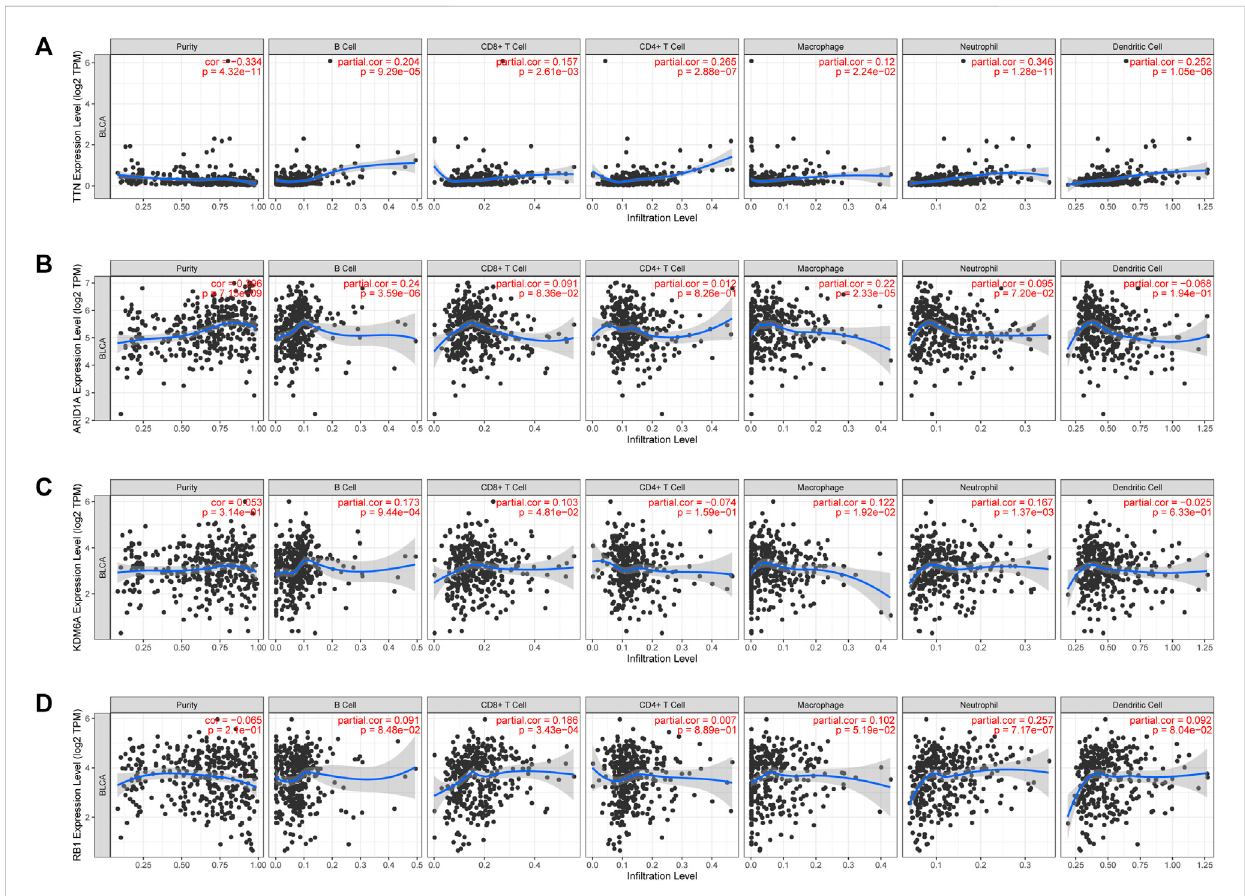
FIGURE 9 The association between four high-mutation genes and immunein fi ltration. The relevancebetweentheexpressionof TTN (A) , ARAD1A (B) , KDM6A (C) , and RB1 (D) and the abundance of immune cells in BLCA.